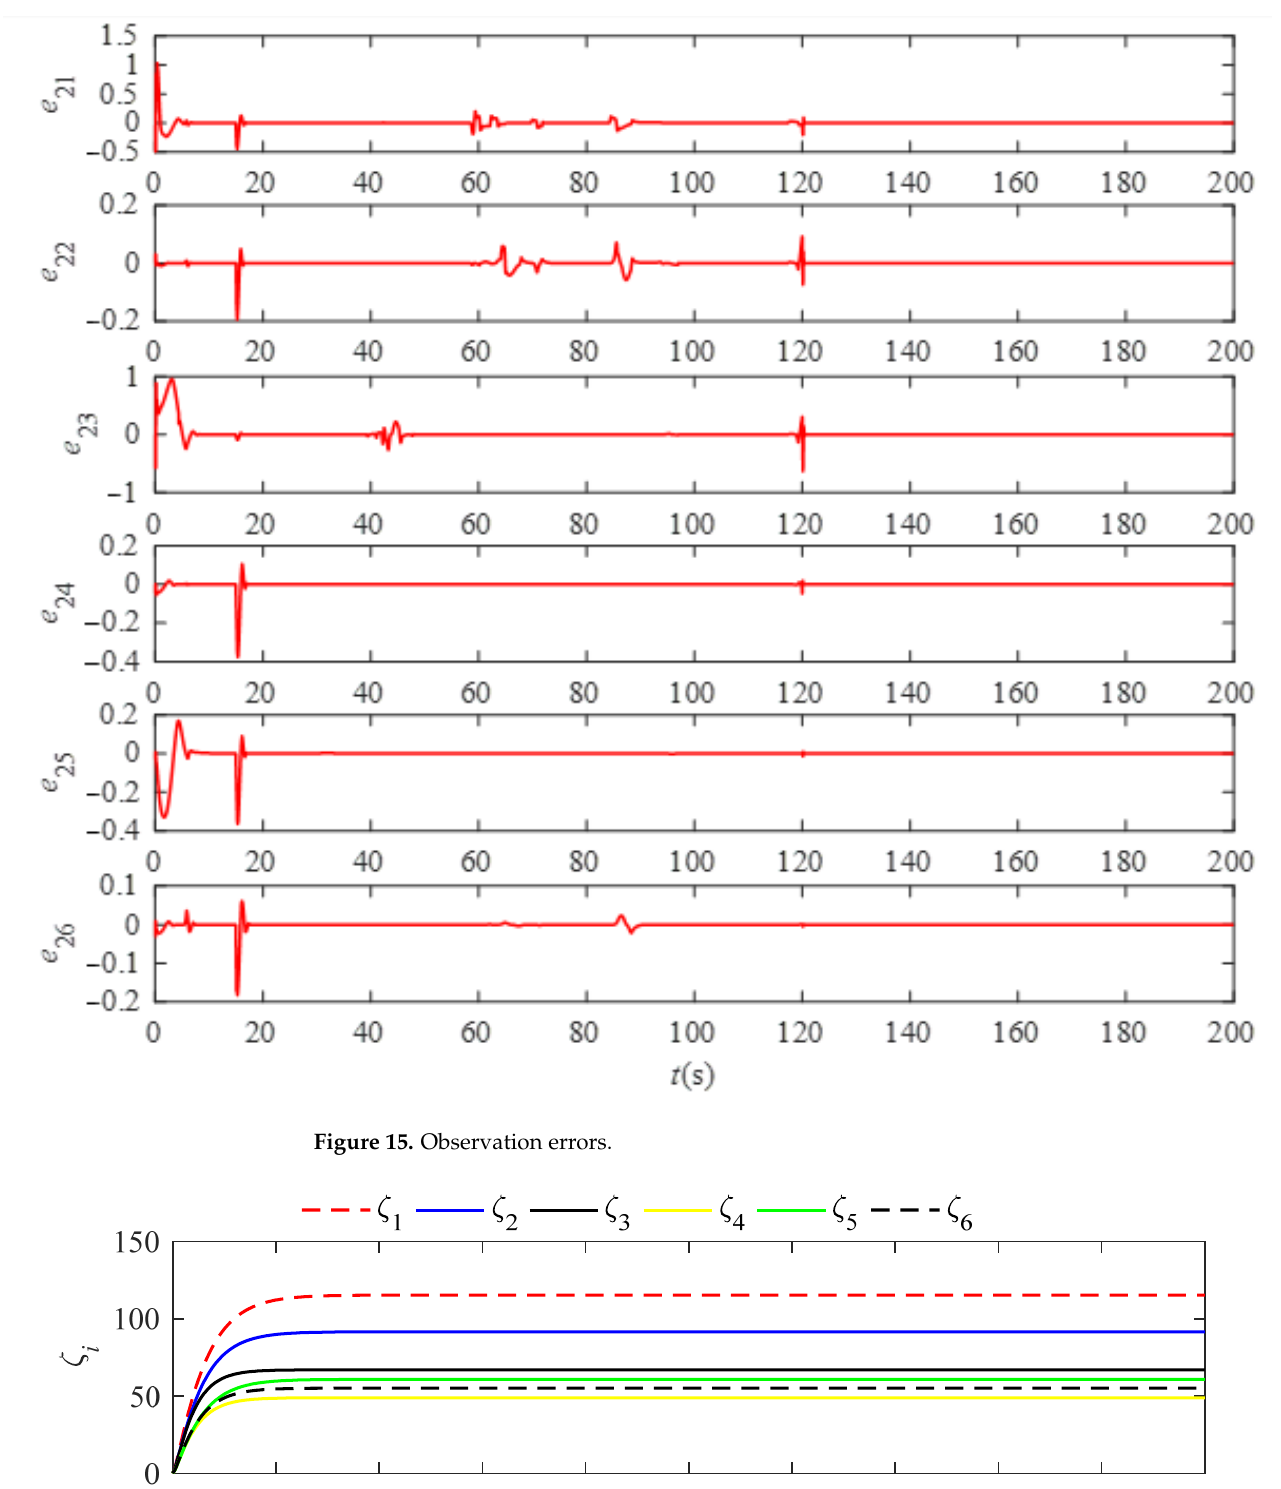
Figure 16. The state of the auxiliary system.